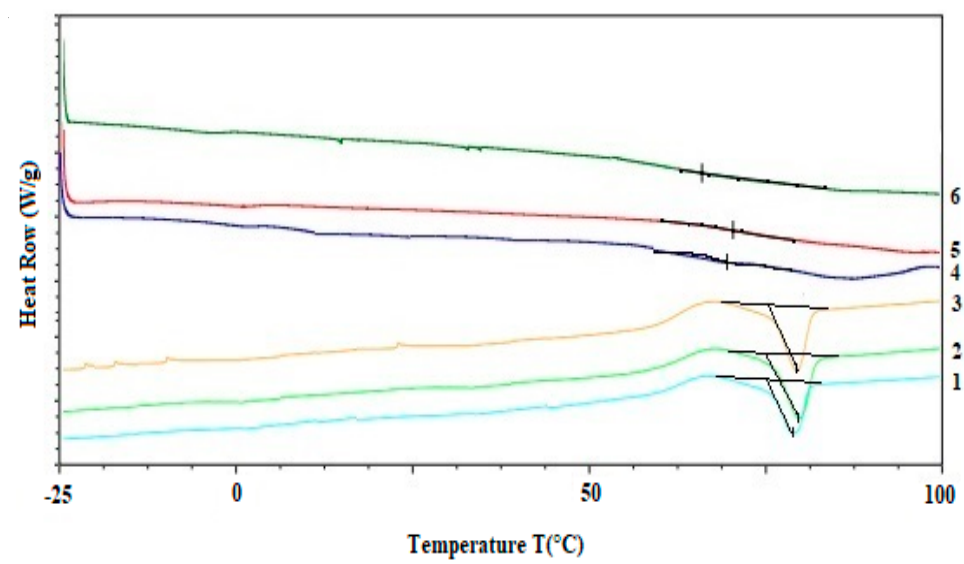
Figure 2. DSC curves of samples before (1—OTSL; 2—OTL; 3—OSL) and after (4—OTSL; 5—OTL; 6—OSL) baking.